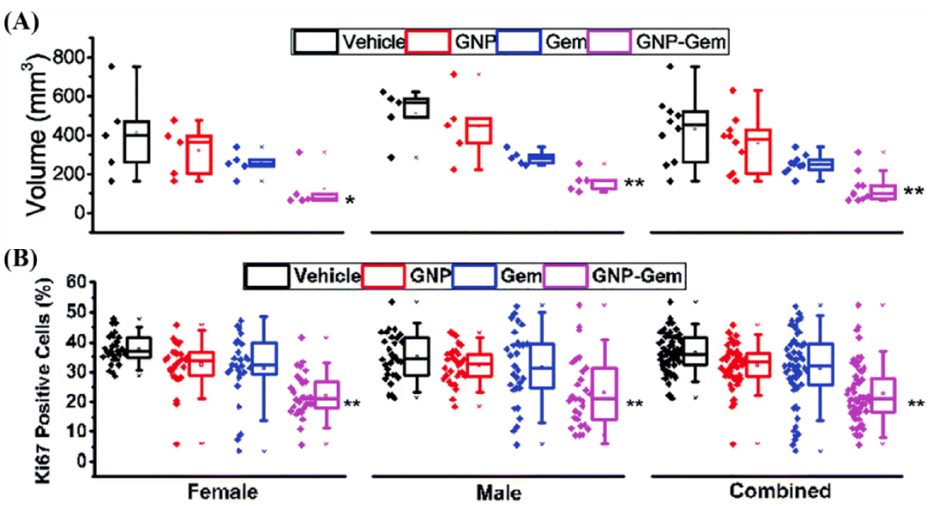
Figure 9. Gold nanoparticle mediated delivery of Gemcitabine. ( A ) Gemcitabine-conjugated GNPs showed a significant increase in e ffi cacy when treating mice, as measured through volume. ( B ) KI67, a marker for proliferation, also showed reduced proliferative cells when treated with the GNP complex compared to the free drug alone, signifying improved e ffi cacy. Black = vehicle, Red = GNP, Blue = Gem and Purple = GNP-Gem. * and ** denote p < 0.05 and p < 0.01 compared to vehicle-treated group respectively. Reproduced with permission from [169]. Copyright Royal Society of Chemistry,